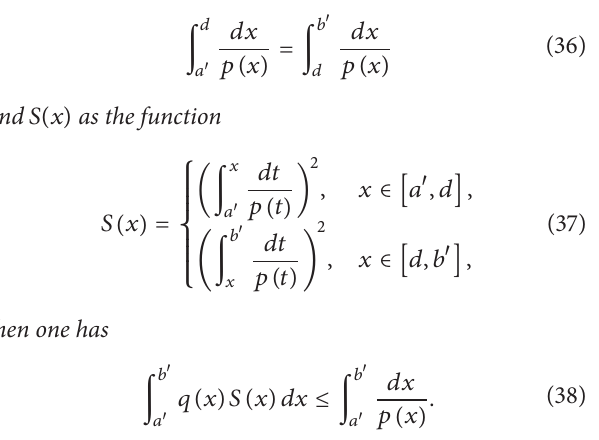
Table 4: Comparison of upper bounds for 𝑏 in Example